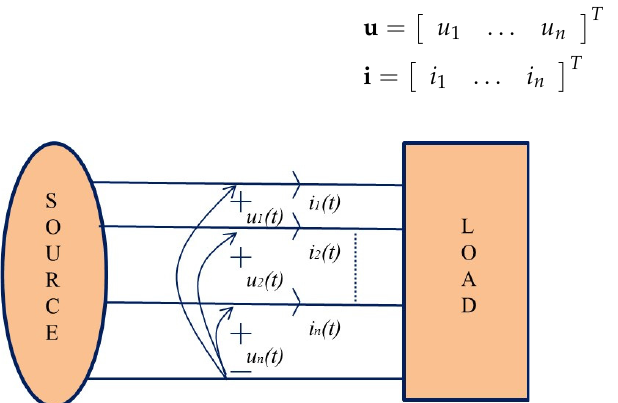
Figure 2. Phase to neutral voltages and line currents in a multi-phase power system.